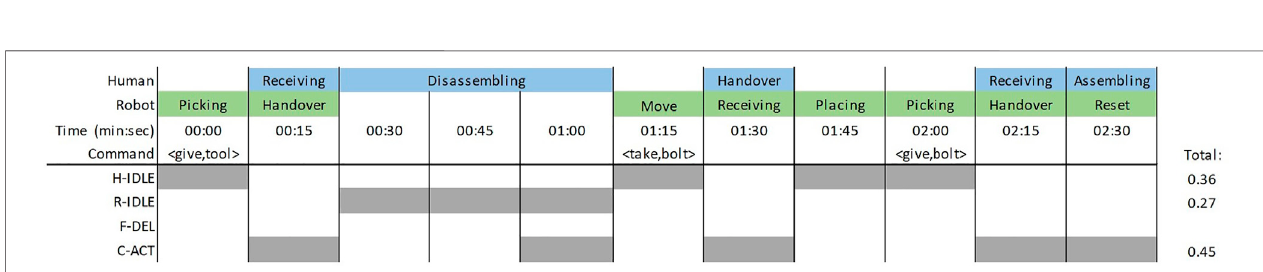
FIGURE3| Differentstagesofthehand-overscenariobygraphicalcommand-basedcoordination.Left:00:00-command < give,tool > issend,whichinstructs therobottohand-overthewrenchfromthetabletotheperson.Middle:01:30-commands < come,here > and < take,bolt > areusedtoinstructtherobottoreceivea bolt from the person. Right: 01:45 - command < give,bolt > is used to instruct the robot to pick up and hand-over a bolt from the table to the person.